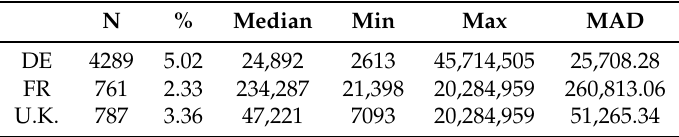
Table 2. Descriptive statistics. DE, Germany; FR,